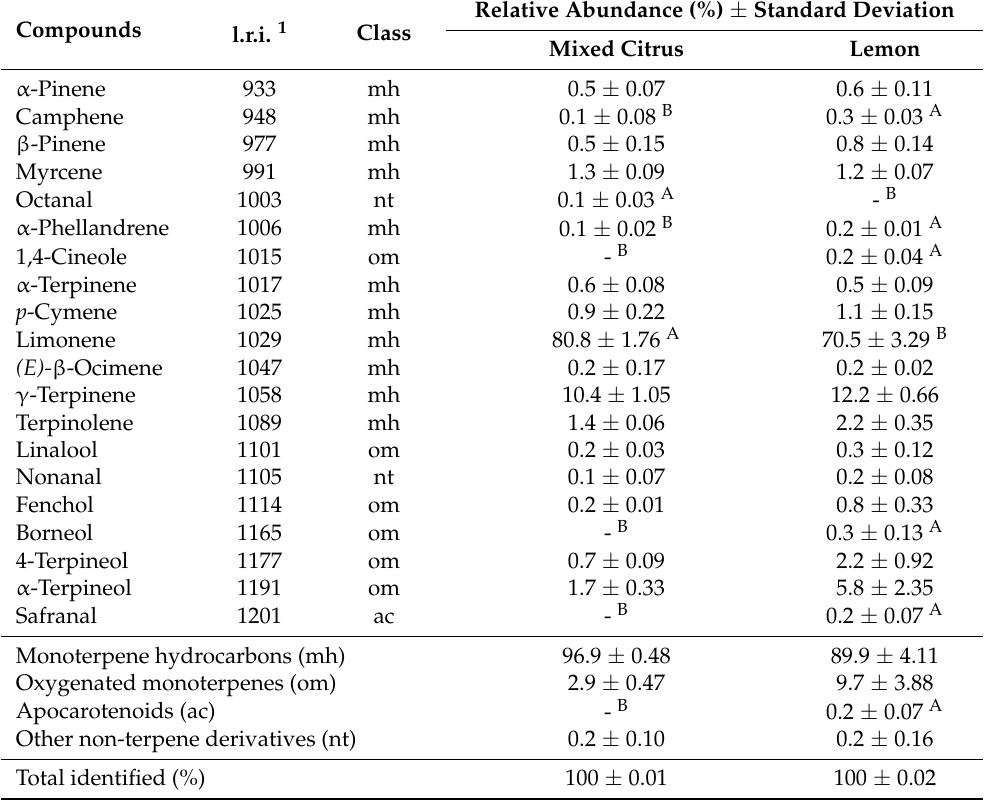
Table 6. Complete composition of the headspaces of the Mixed Citrus and Lemon samples.